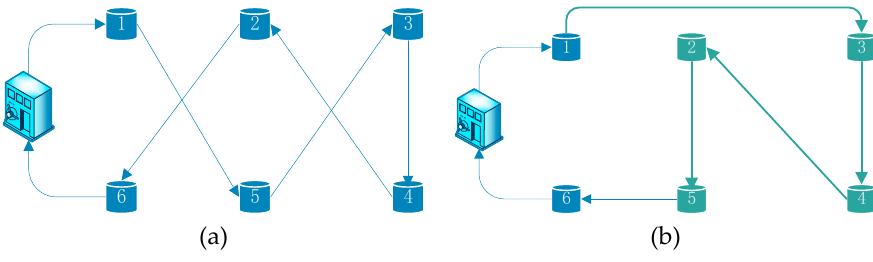
Figure 4. Insert operation. ( a ) Route before insert operation and ( b ) route after insert operation.